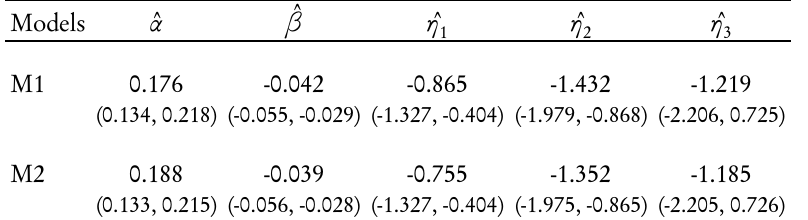
Posterior summary of the regression parameters of models M1 and M2. In brackets we show the 2.5 and 97.5 percentiles used for defining the 95% credible interval